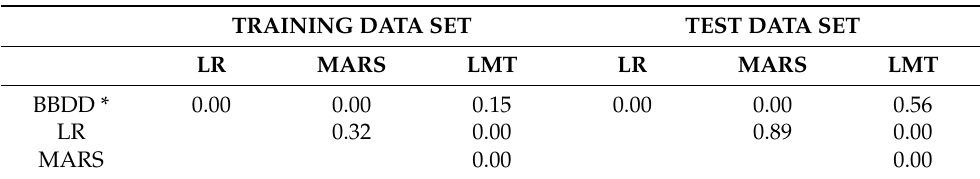
Table 4. Results of the Wilcoxon signed rank test applied to the observed and predicted data generated by each model. Numbers within each cell represent the p -value associated with the null hypothesis being true: no difference between the data generated by a given pair of models. LR: logistic regression; MARS: multivariate adaptive regression splines; and LMT: logistic model